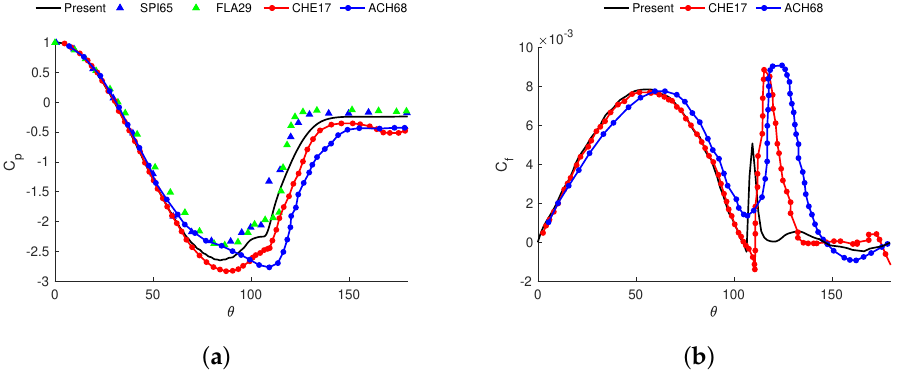
Figure 4. ( a ) Pressure coefficient and ( b ) skin-friction distribution along the cylinder surface. Compar- ison with the literature. SPI65 (Spitzer [33]), FLA29 (Flachbart experiments taken from [18]), CHE17 (Cheng et al. [8]), ACH68 (Achenbach [3]).